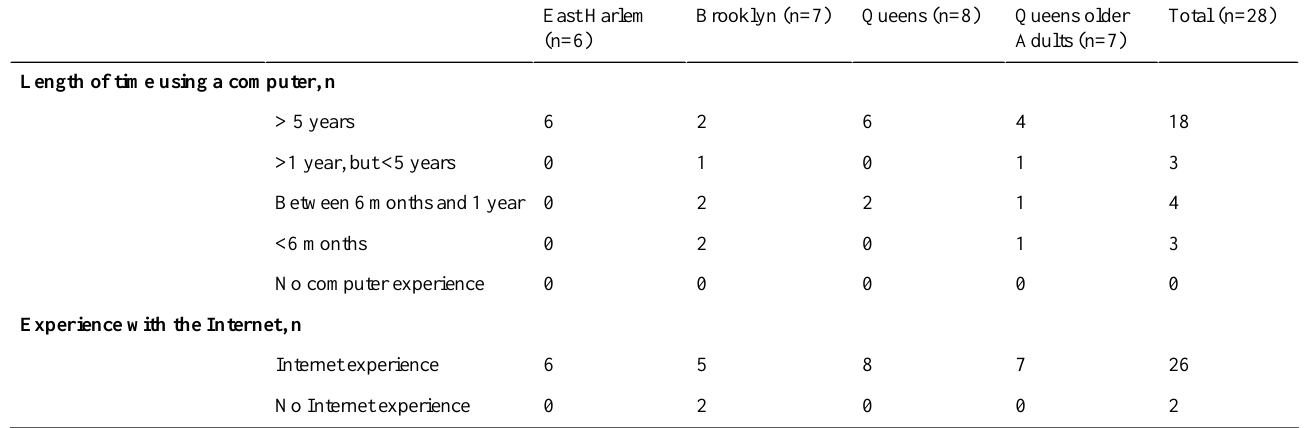
Table 3. Use of computers and the Internet